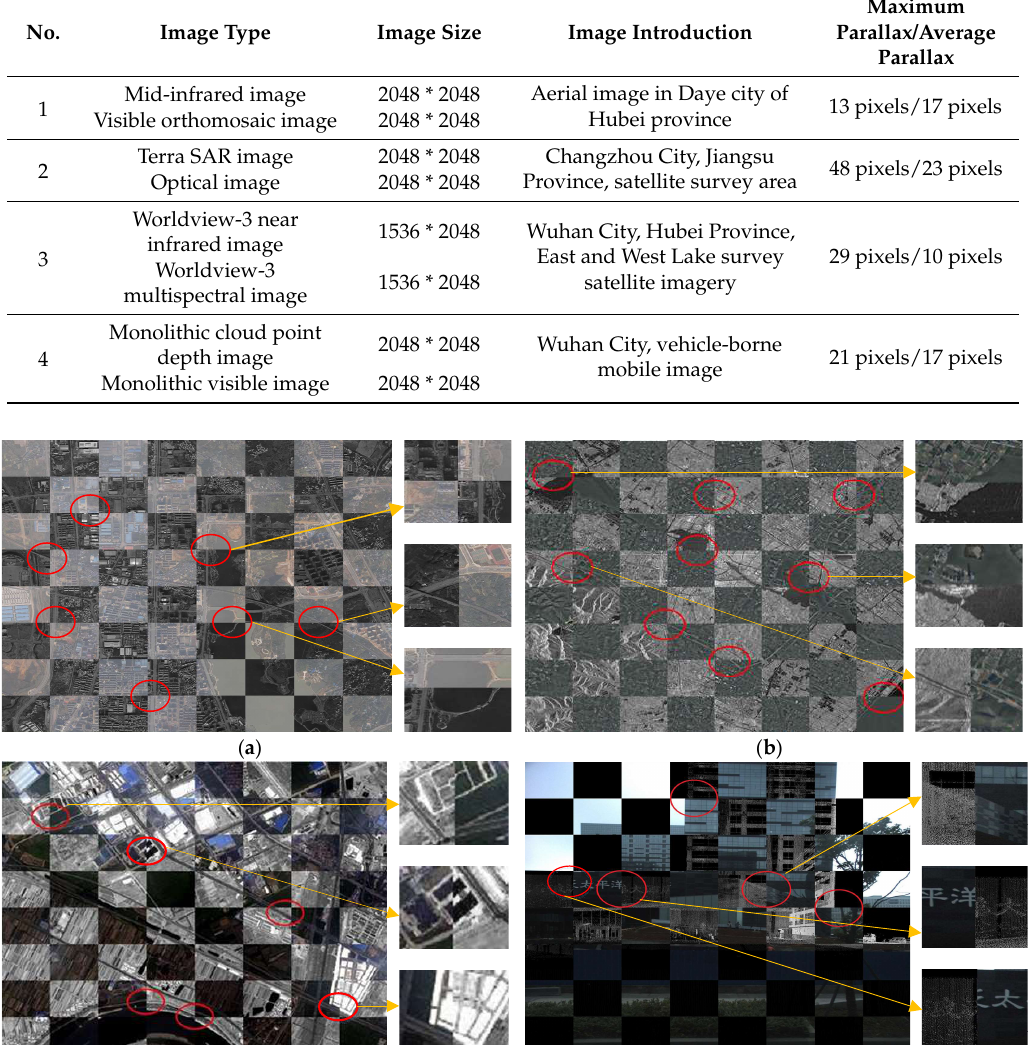
Table 1. The multimodal datasets.